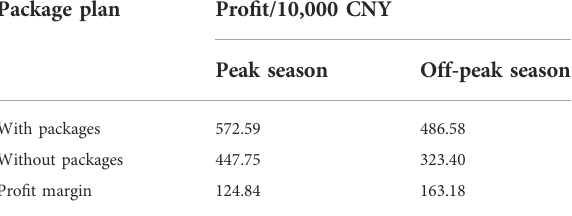
TABLE 5 Pro fi ts with and without packages.